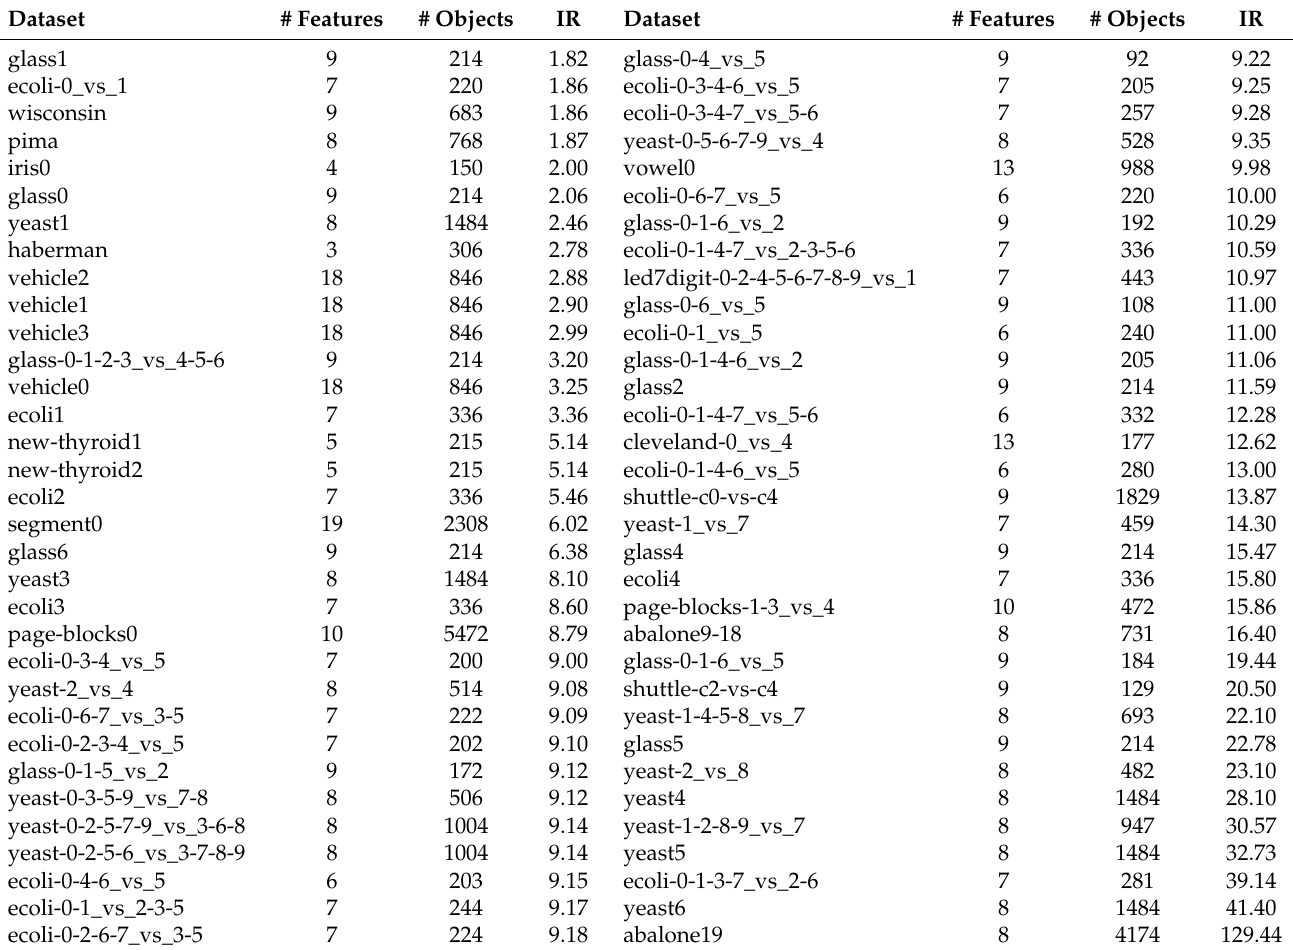
Table 2. Datasets from the KEEL repository used in our